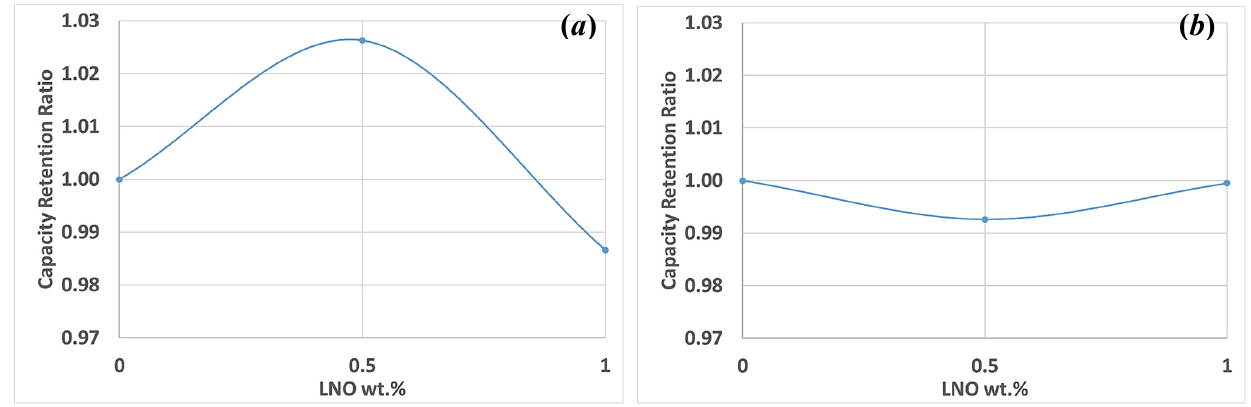
Figure 10. Capacity retention ratio of the coated-NMC-60 for ( a ) Method-I, and ( b ) Method-II.